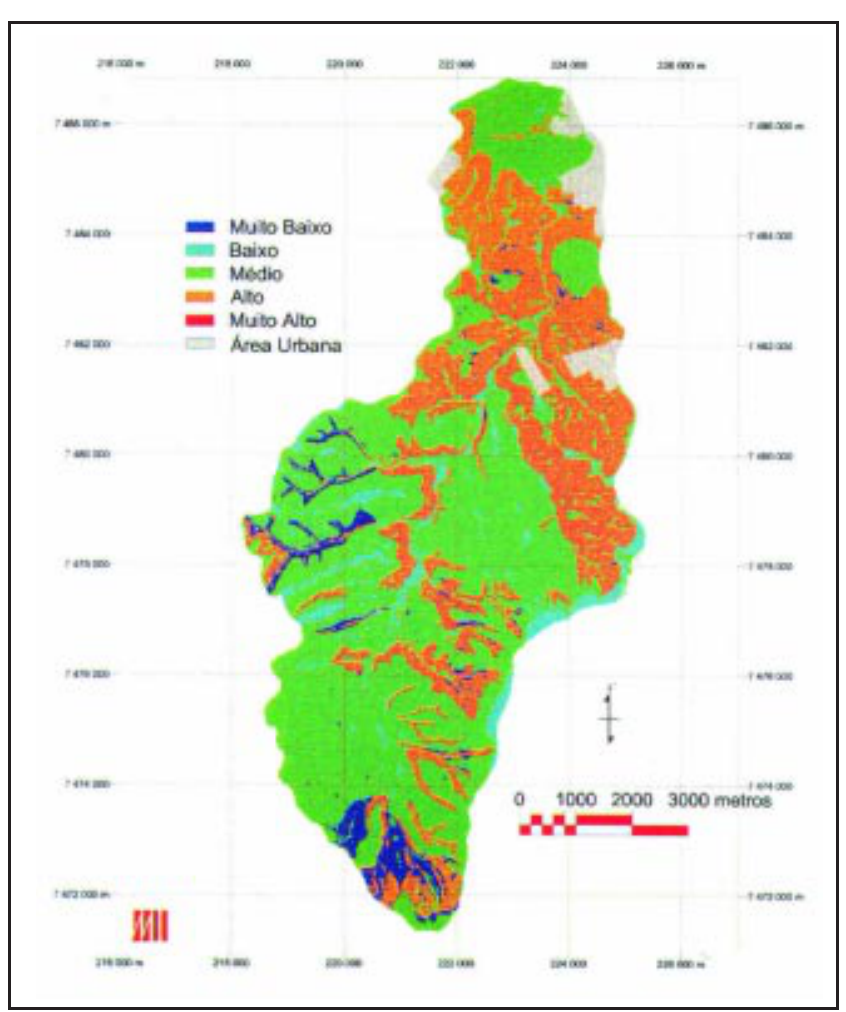
Figura 2. Mapa de risco de degradação das terras para o cenário de uso redistribuído (SIG- TNTmips